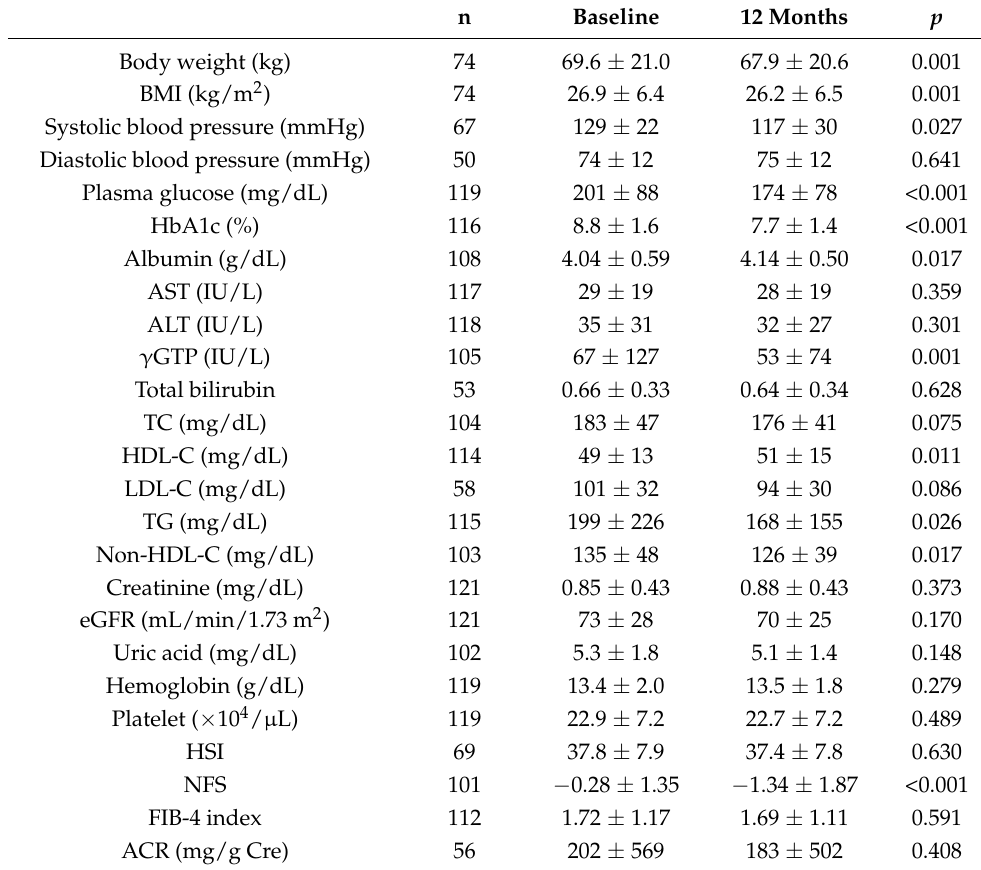
Table 2. Change in the clinical parameters 12 months after the start of dulaglutide (n = 121).